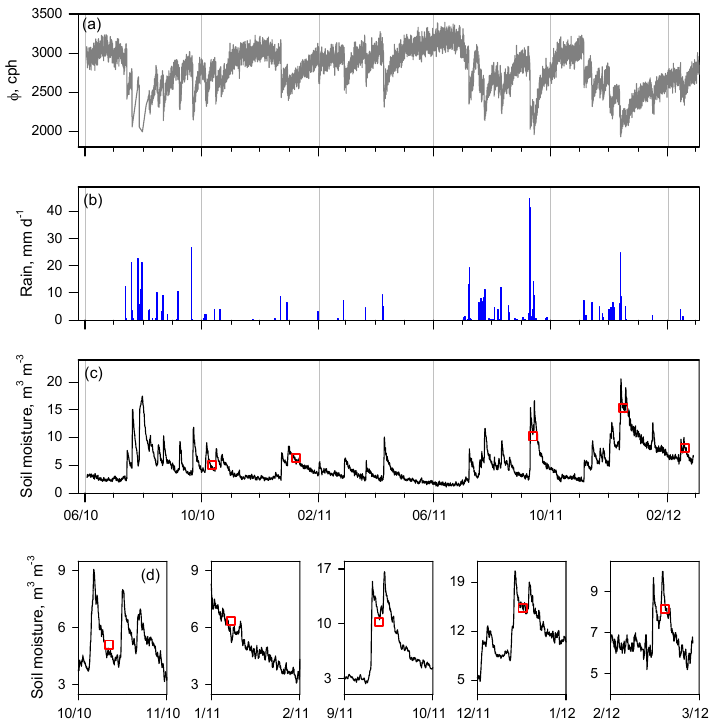
Fig. 11. COSMOS data from the Santa Rita site, near Tucson, Arizona, USA. Fast neutron intensity (a) was corrected for temporal changes in Fig. 12. Corrections for variations in pressure (a) , atmospheric water vapor (b) , the incident cosmic-ray neutron intensity (c) , and the the incoming neutron intensity, atmospheric pressure and atmospheric water vapor. The rainfall intensity (b) is the average of 12 rain gauges combined correction (d) computed for the Santa Rita COSMOS site in distributed within 200m of the COSMOS probe. Neutron-derived soil moisture (c, d) are computed using Eq. (4) with neutron intensity normalized using Eq. (A1), and is smoothed using a 12-h running average filter. Five separate soil moisture data sets (red squares), each based on multiple soil samples collected within the COSMOS footprint and measured gravimetrically following oven drying, are shown for comparison with the neutron-derived data.